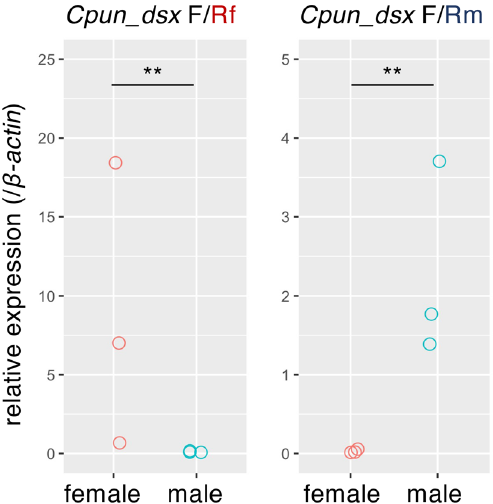
Figure 3. Expression patterns of Cpun_dsx in the female and male gonads of C. punctulatus adults. Left and right panels show the relative expression levels of its female- and male-specific isoform to those of β-actin , respectively. “F”, “Rf”, and “Rm” indicate the primers shown in Fig. 1. Replications of gonads are derived from individuals collected from three different kin groups. The expression levels were compared between sexes using GLM analyses. ** indicates p <